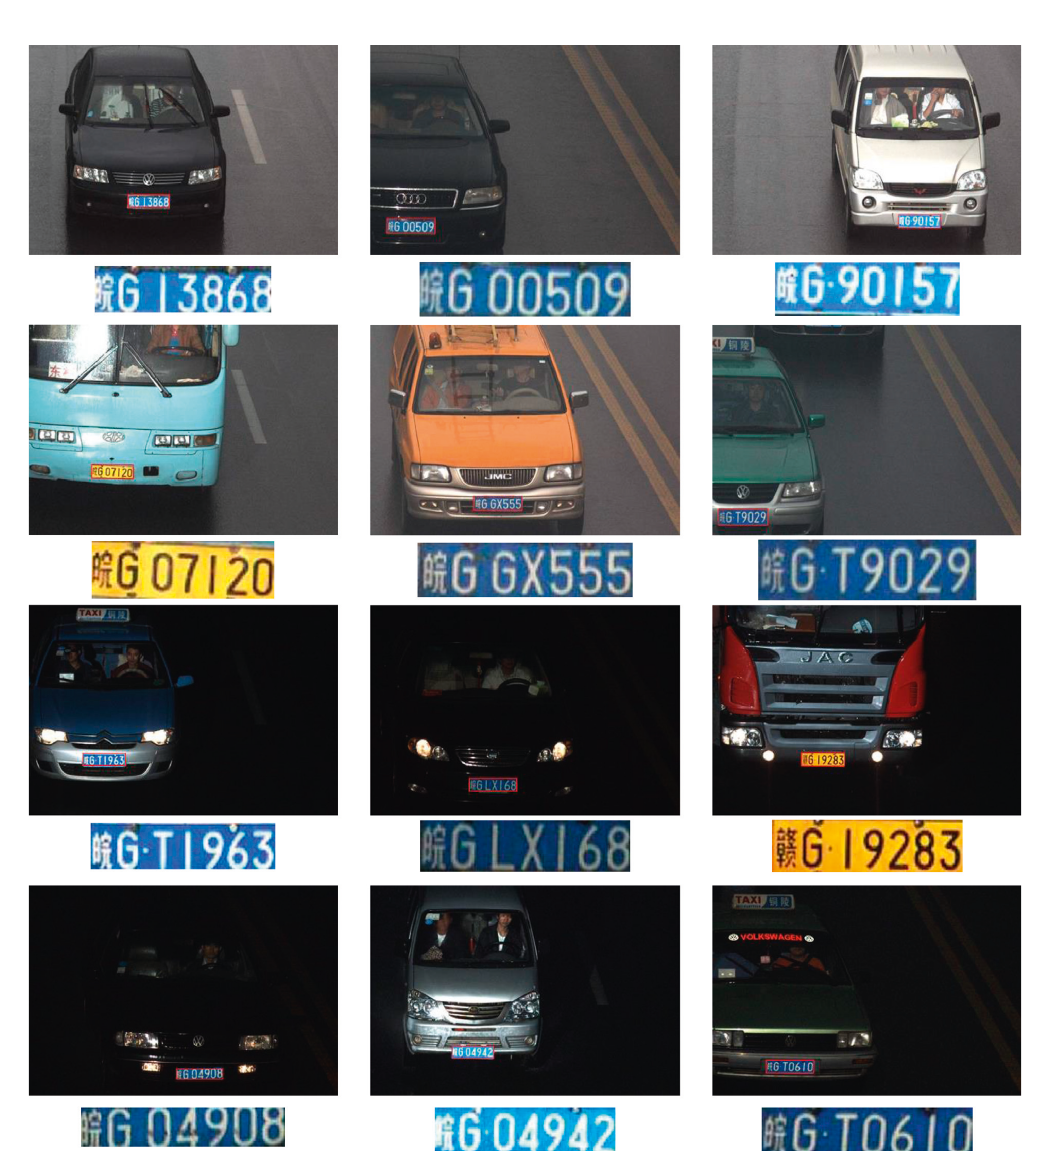
Figure 4: Examples of detection results of the proposed method on PKU vehicle